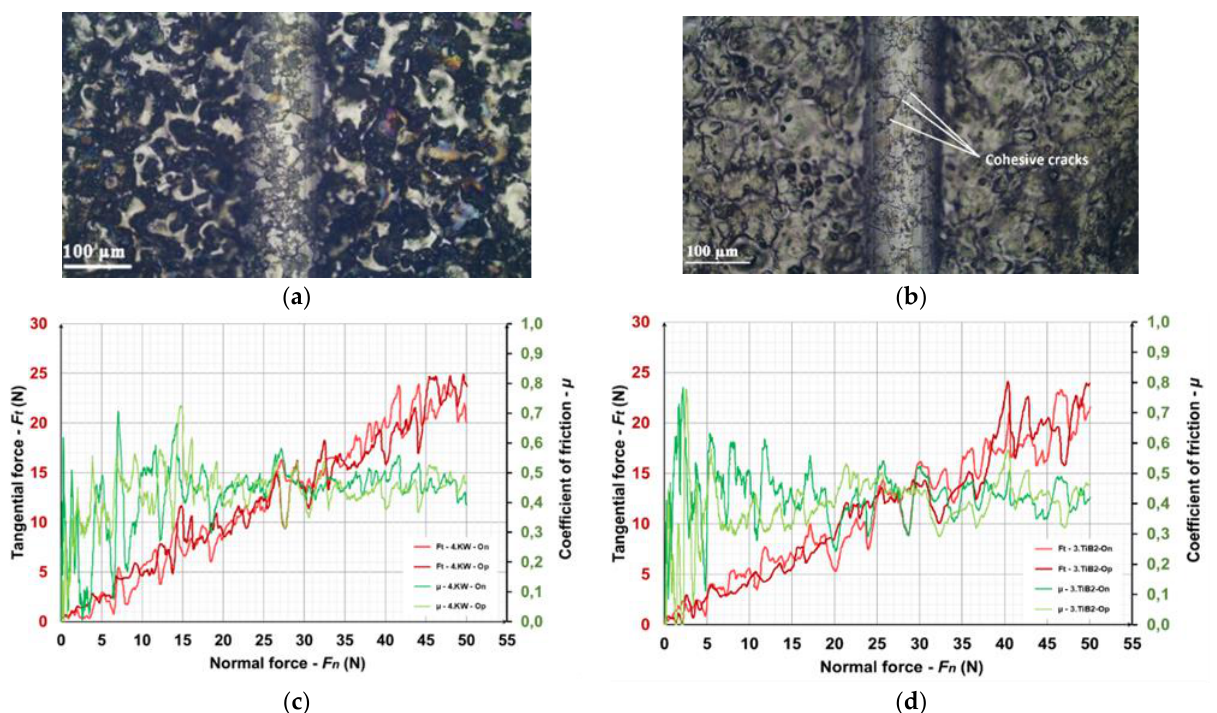
Figure 5. The scratch track, the coefficient of friction (μ), tangential force (Ft) of coatings from KW10T10B10 and TiB 2 – TiAl nano electrode, E = 0.07 J. ( a ) The scratch track of KW10T10B10 coating; ( b ) The scratch track of TiB 2 – TiAl coating; ( c ) Coating from KW10T10B10 electrode; ( d ) Coating from TiB 2 -Til naoo coating.